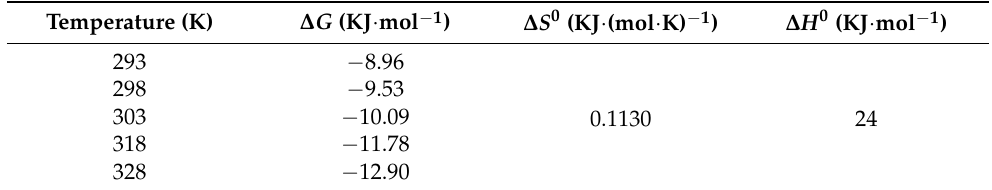
Table 4. Values of thermodynamic parameters for the adsorption of Sr on soil colloid, T = 293/298/303/318/328 K, soil-liquid rate = 0.8 g · L − 1 , pH = 6 ± 0.1, strontium nitrate concentration = 100 mg · L − 1